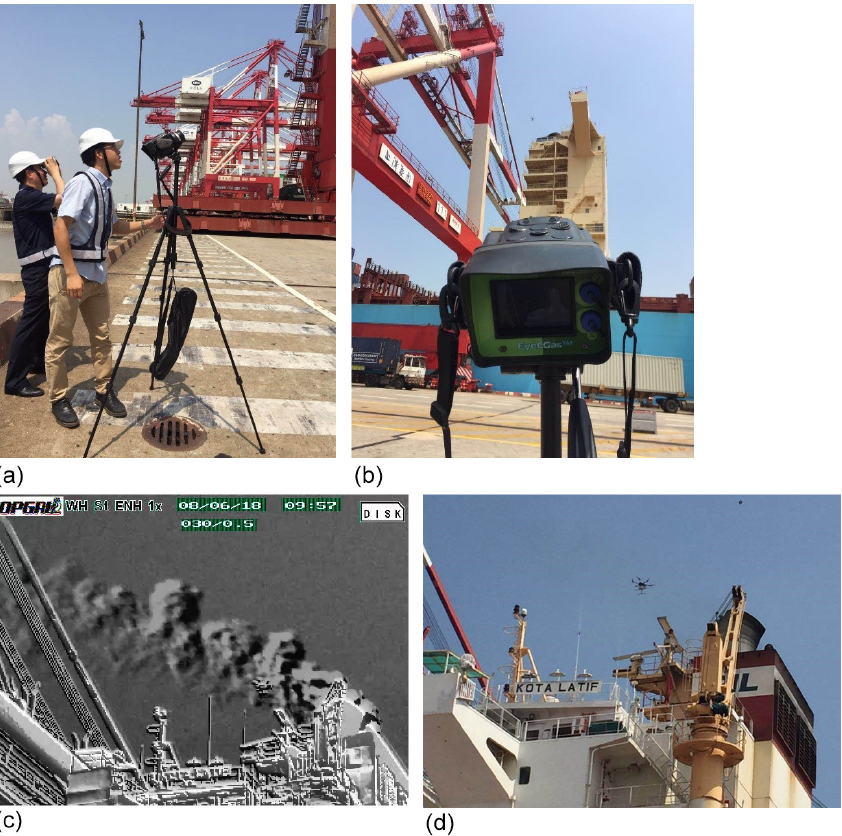
Figure 3. Photographs showing the setup of the experiment. An infrared camera is set up for locating the smoke plume (a, b) . The target plume is imaged by the infrared camera (c) . The UAV takes off towards the smoke plume (d)